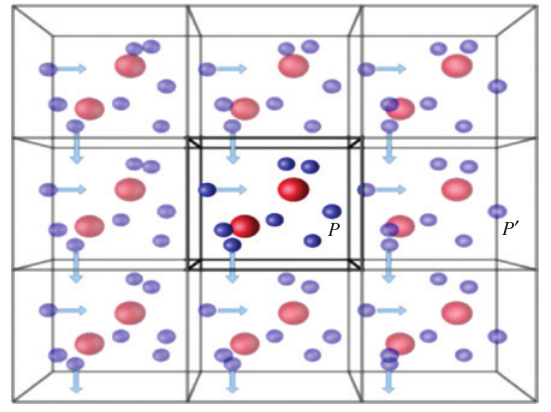
Figure 8: Unit-cell microstructure [26]. Figure 9: Schematic representations of the faces